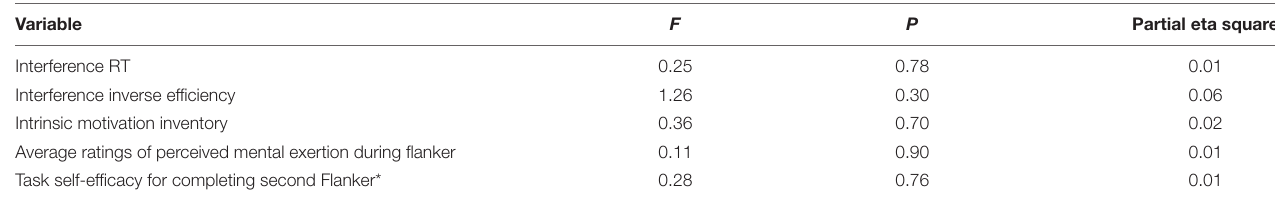
TABLE 3 | Primary and secondary analyses: repeated measures ANOVA effect of time by